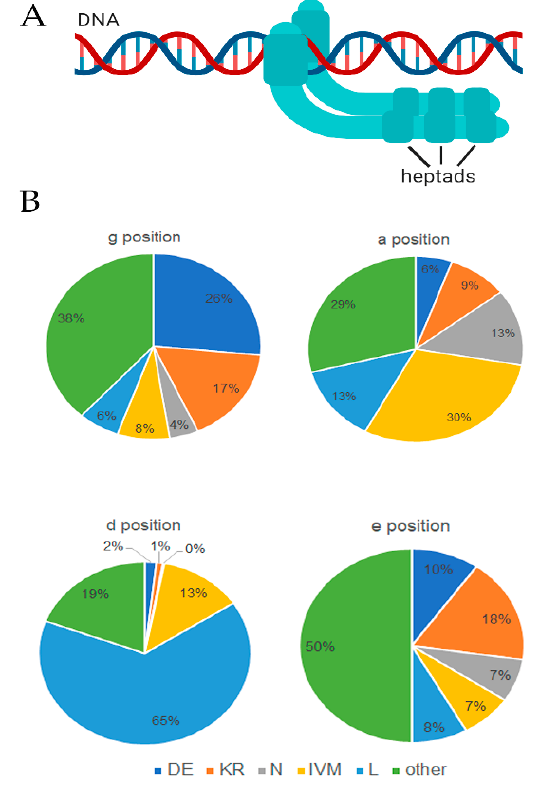
Figure 4. Analysis of amino acid composition for heptads. ( A ) Depiction of bZIP transcription factor binding DNA and dimeric heptads. ( B ) Pie chart presenting the frequency (%) of amino acids in the g, a, d, e position of heptads from the 80 StbZIP proteins.